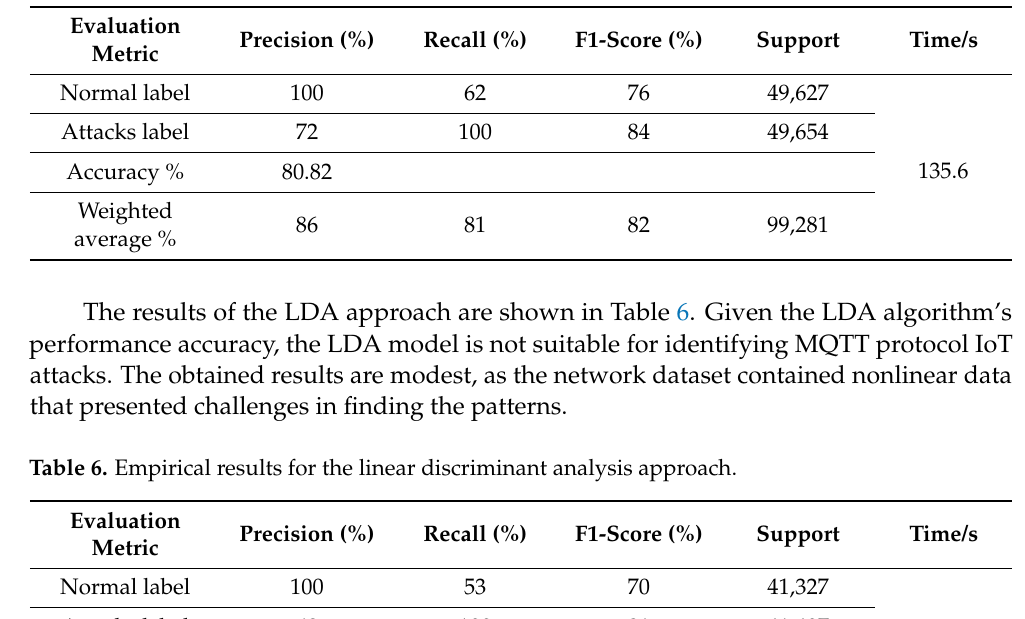
Table 5. Empirical results for the k-nearest neighbors algorithm.